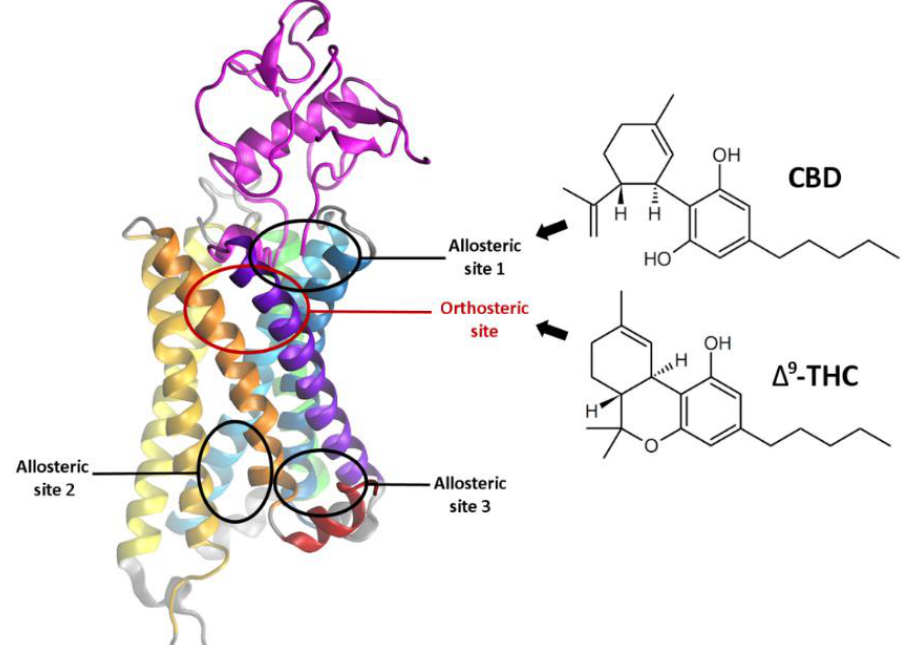
Figure 3. CB1 cannabinoid receptor with modelled N-terminus and the locations of orthosteric and allosteric binding sites. Cannabidiol (CBD)—an allosteric ligand, and ∆ 9-tetrahydrocannabinol ( ∆ 9 -THC)—an orthosteric ligand of CB1R. According to Lapraire et al. and Sabatucci et al. CBD very likely binds to the allosteric site 1 [10,31].